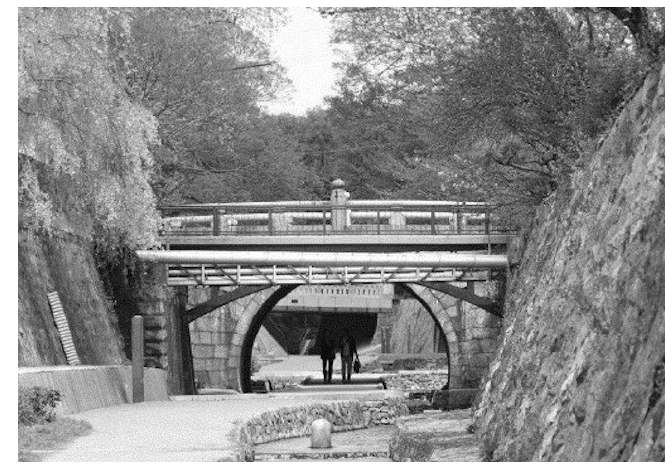
Figure 4. Horikawa canal in 2013 Source: Biglobe News 2013/04/23